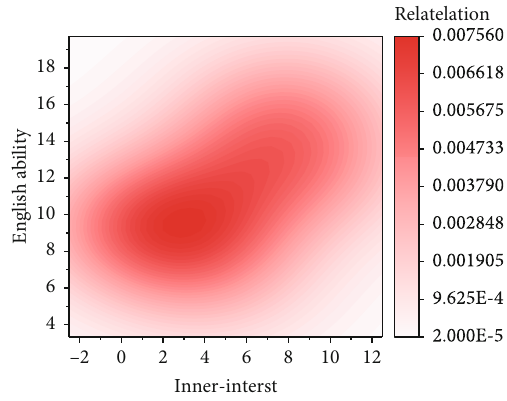
Figure 9: Changes in the interactive experience of the fl ipped